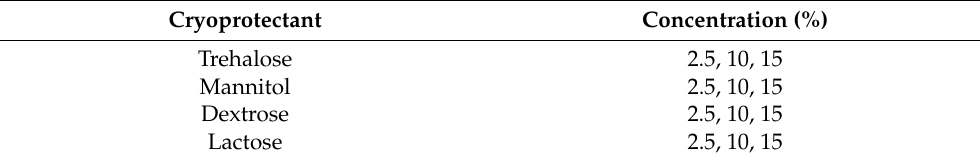
Table 2. Cryoprotectants used in the freeze-drying.